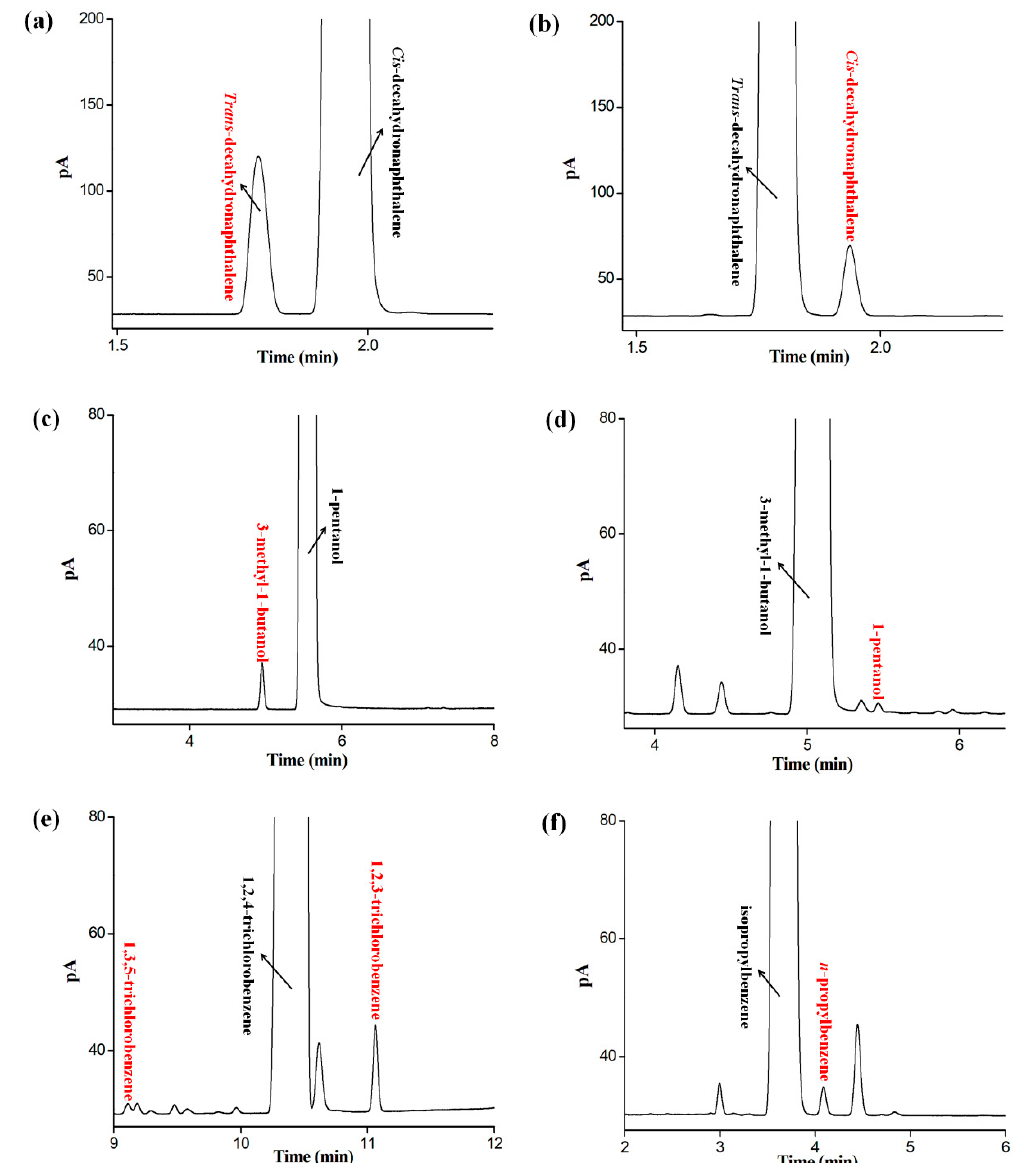
Figure 6. Applications of the PCL-PEG-PCL column for the determination of minor isomer impurities in the real samples of ( a ) cis -decahydronaphthalene, ( b ) trans -decahydronaphthalene, ( c ) 1-pentanol, ( d ) 3-methyl-1-butanol, ( e ) 1,2,4-trichlorobenzene, and ( f ) isopropylbenzene, respectively. Table 3. Results for the detection of isomer impurities in the commercial reagent samples on PCL-PEG-PCL column.